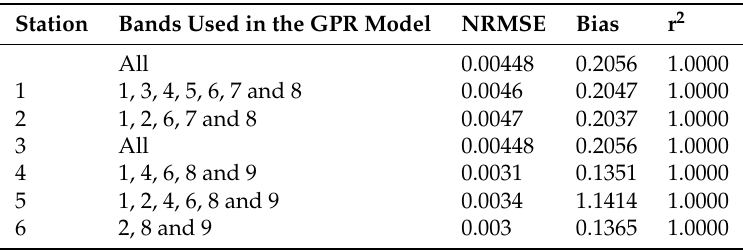
Table 7. Summary of the computed statistical measures for the six GPR models. The p -value was significantly below 0.0001 for all cases.